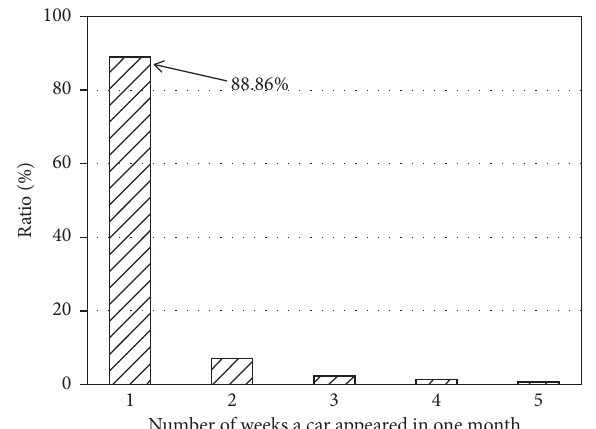
Figure 5: Number of weeks visited by tourists in one month.